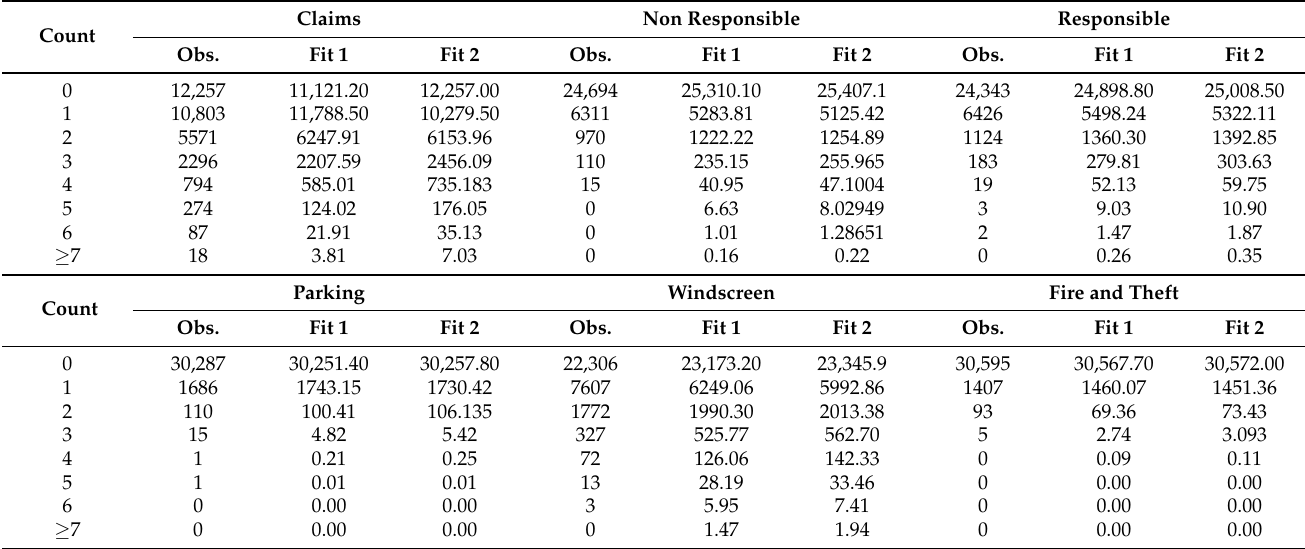
Table 5. Empirical and fitted homogeneous marginal distributions using the basic model (Fit 1) and zero-inflated model (Fit 2).